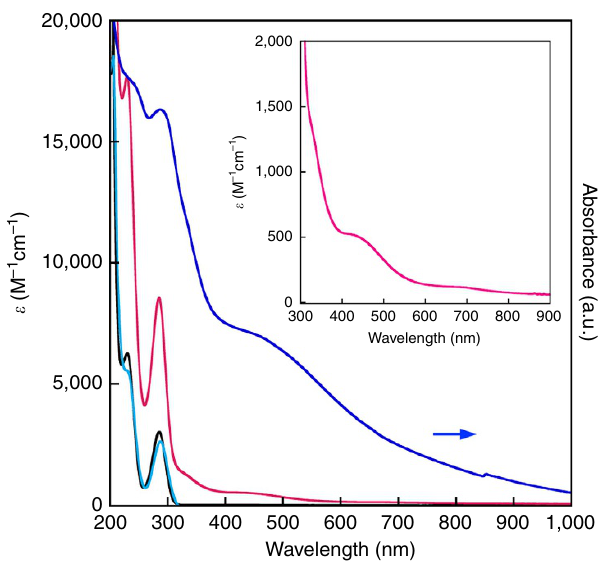
Figure 3 | H 2 evolution from MeOH solutions of apH 2 -based photocatalysts. Mols of evolved H 2 per mols of catalyst as a function of PHER time for MeOH solutions of apH 2 (2mM; black circles), apH (cid:2) (2mM; turquoise circles), 1 (1mM; magenta circles), and (cid:3) Fe II (ClO 4 ) 2 6H 2 O (1mM; blue circles), together with pure MeOH (grey circles). Irradiation wavelength, 289 ± 10nm (3.2mW). Estimated relative s.d.,